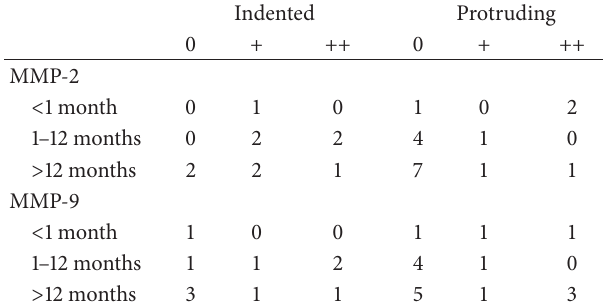
Table 4: Immunohistochemistry results for MMP-2 and MMP-9 in anetoderma lesional dermis according to clinical phenotype and disease